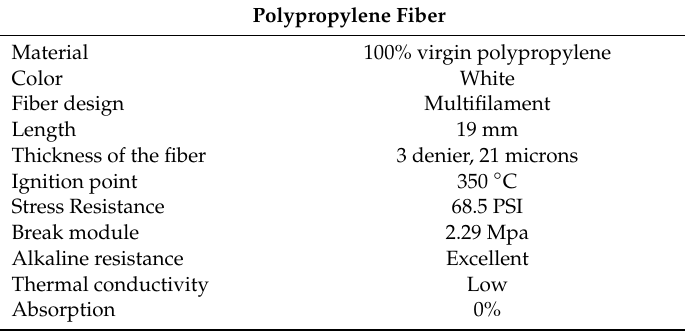
Table 5. Fiber properties according to